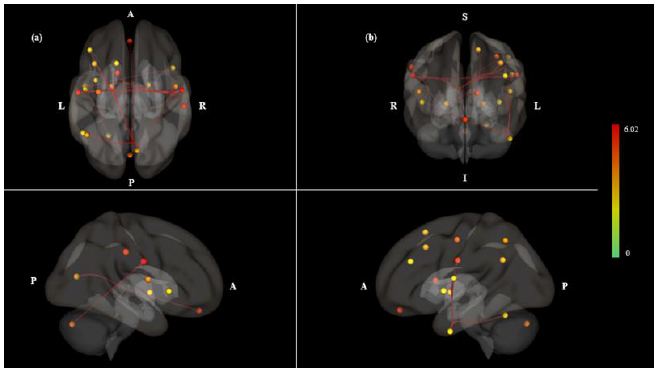
Figure 2. ROI-to-ROI 3D rendering maps of all selected ROI seeds in Mouth > Nose contrast, which was the same result as Figure 1a . 3D maps presented ( a ) dorsal, ( b ) anterior, ( c ) right and ( d ) left. The maps are obtained at a ROI-to-ROI connections height threshold (FDR) of P < 0.05, seed ROI height threshold (uncorrected) of P < 0.05, with one-sided positive seed level correction and permutation tests. The color bar indicates the statistical T value. Abbreviations: ROI, region of interest; FDR, false discovery rate.